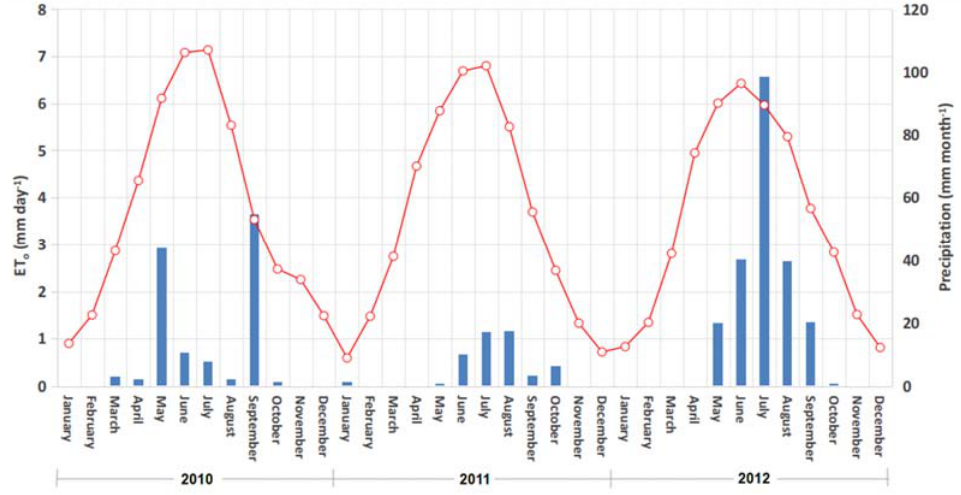
Figure 2. Monthly precipitation ( ) and daily reference evapotranspiration ( ) observed in the